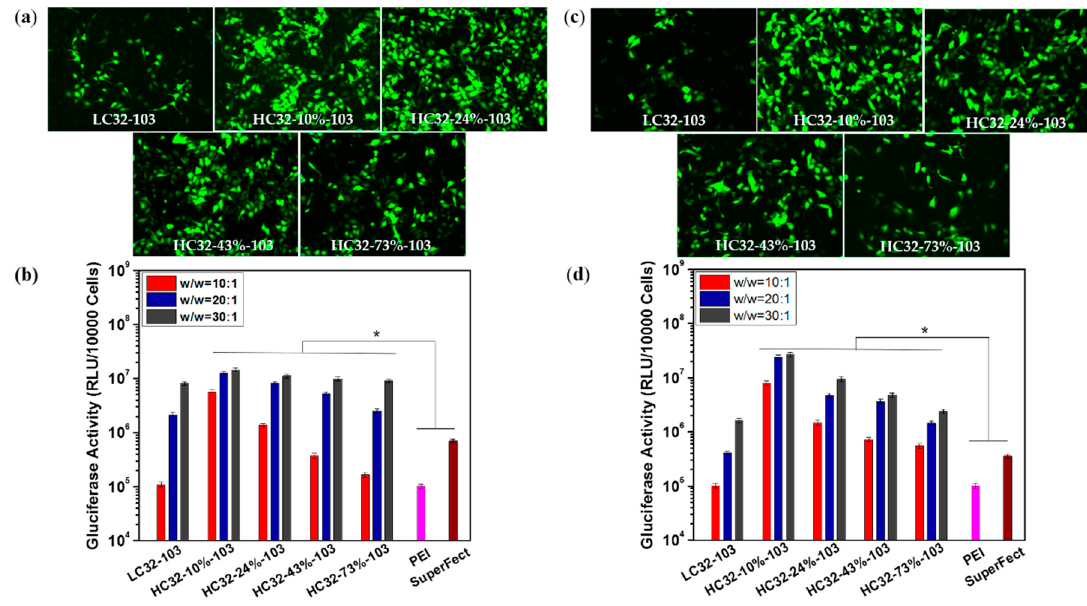
Figure 2. Transfection efficiency of LC32/DNA, HC32-103/DNA, PEI and SuperFect/DNA polyplexes formulated with different w / w ratios 48 h post-treatment: ( a ) GFP expression of HeLa cells treated with polyplexes; ( b ) Gluciferase activity of HeLa cells after treatment with polyplexes; ( c ) GFP expression of RDEBK cells; ( d ) Gluciferase activity of RDEBK cells after treatment with polyplexes, 40 × magnification. Data points marked with an asterisk are statistically significant relative to the PEI and SuperFect group ( p < 0.05).